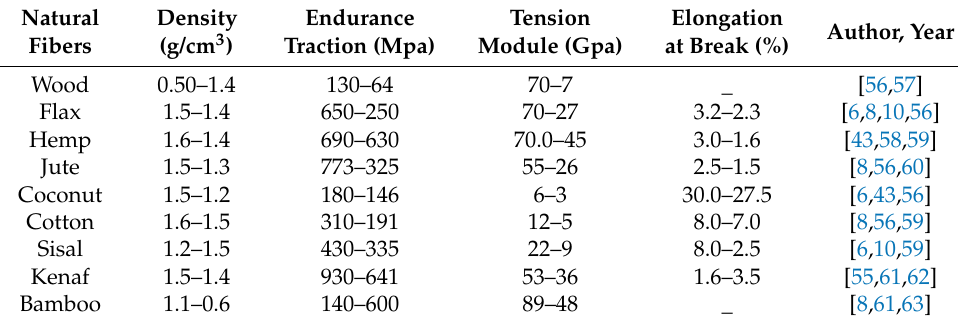
Table 3. Physical and mechanical properties of some natural